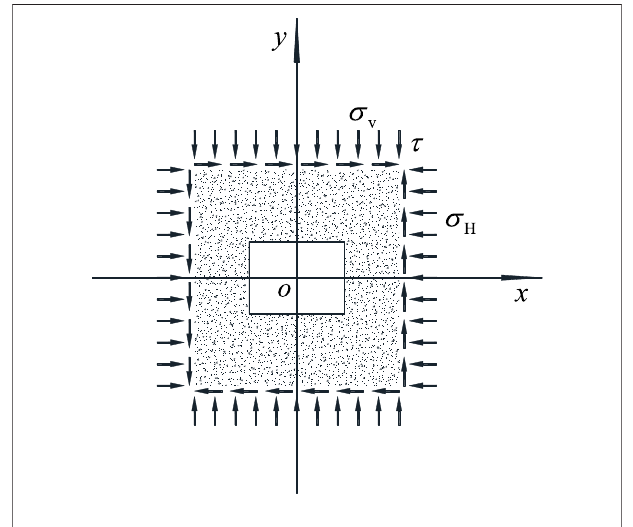
FIGURE 4 | Stress diagram of the rectangular